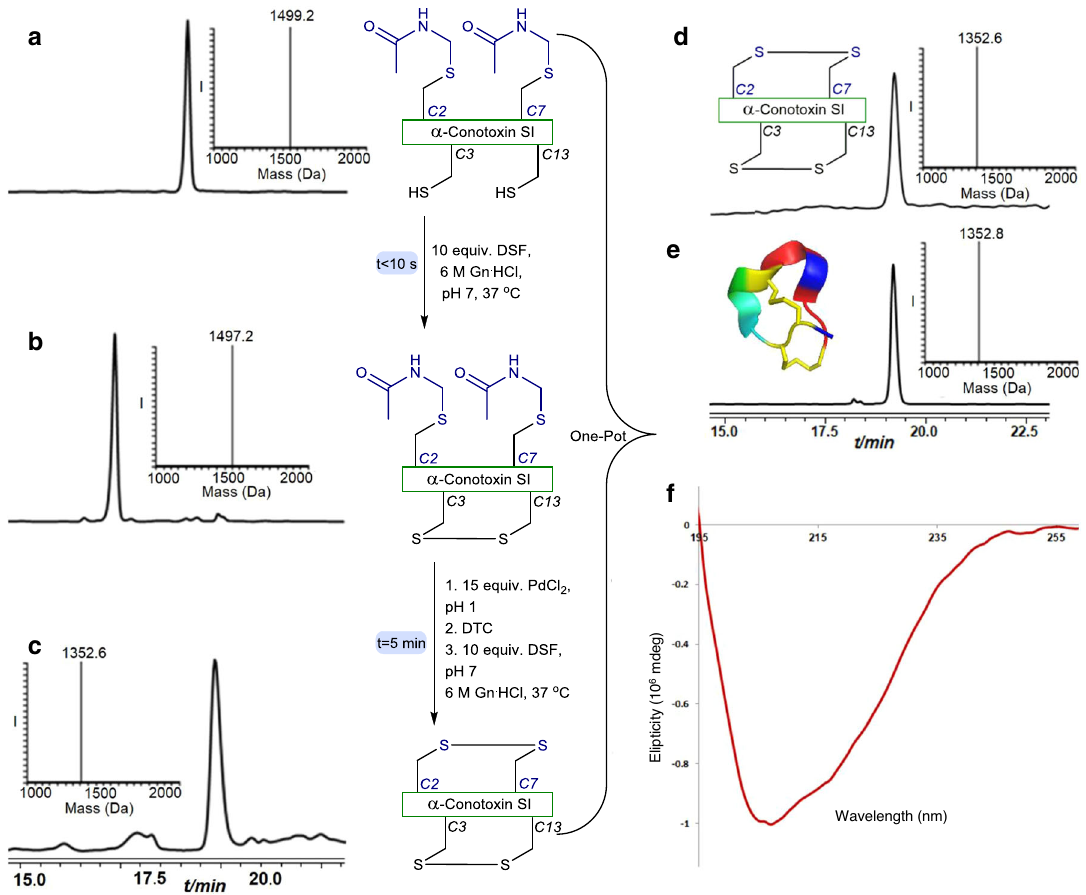
Fig. 2 Two disul fi de bonds formation in α -conotoxin. a HPLC-ESI MS analyses: Reaction at time zero, the main peak corresponds to reduced α -conotoxin peptide modi fi ed with two Acm groups at Cys (2&7) with the observed mass 1499.2 ± 0.1 Da, calcd. 1499.6 Da (average isotopes). b Reaction after 10 s: the main peak corresponds to α -conotoxin peptide bearing one disul fi de bond modi fi ed with two Acm groups at Cys (2&7) with the observed mass 1497.2 ± 0.1 Da, calcd. 1497.6 Da (average isotopes). c In situ addition of 15 equiv. PdCl 2 for 5 min followed by DTC/DSF treatment: the main peak corresponds to α -conotoxin peptide bearing two disul fi de bonds with the observed mass 1352.6 ± 0.1 Da, calcd. 1353.6 Da (average isotopes). d Puri fi cation and folding: the main peak corresponds to α -conotoxin peptide bearing two disul fi de bonds with the observed mass 1352.6 ± 0.1 Da, calcd. 1353.6 Da (average isotopes). e commercially available native α -conotoxin with the observed mass 1352.8 ± 0.1 Da, calcd. 1353.6 Da (average isotopes) ( f ) synthetic α - conotoxin CD